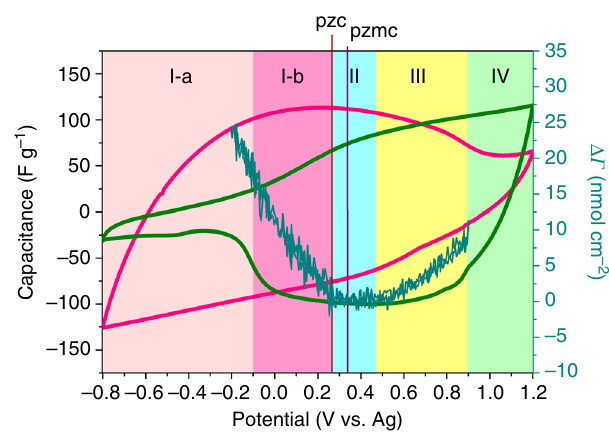
Fig. 7 Combination of electrochemical quartz crystal microbalance (EQCM) data with the cyclic voltammetry (CV) curves shown in